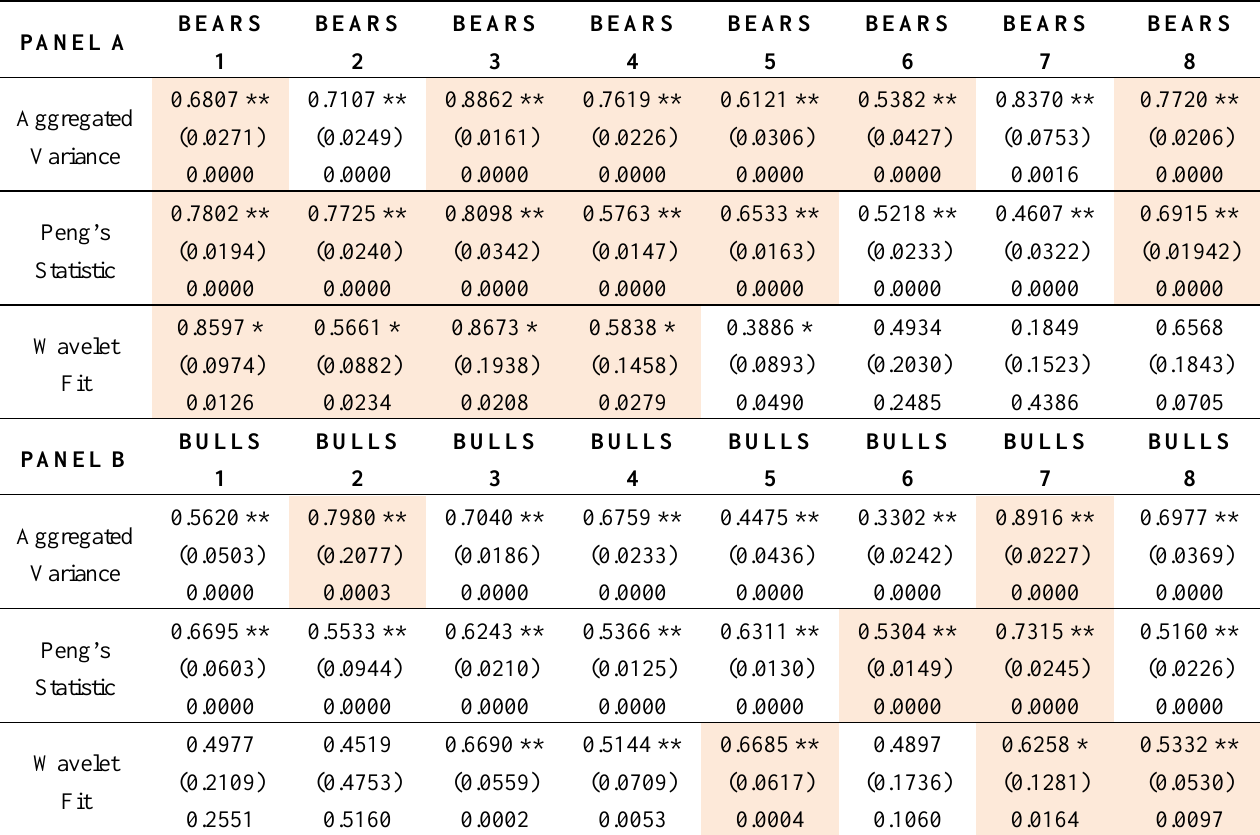
Table 5. Scaling exponent H results of the bull and bear periods of the oil data.